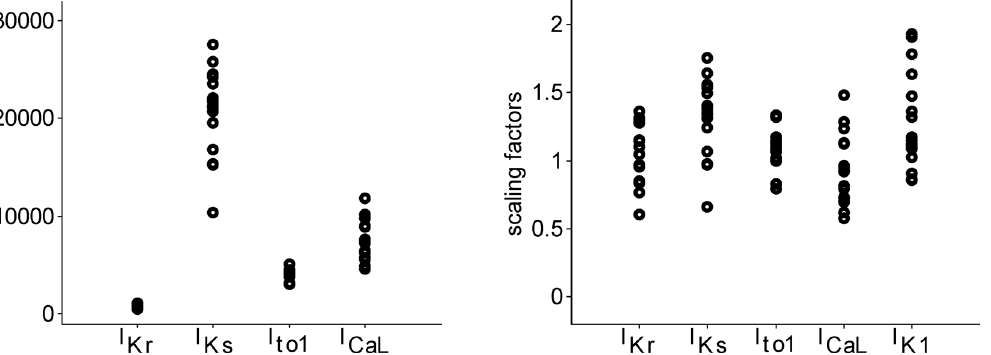
Fig 3. Channel numbers and current conductance scaling factors. Number of channels (left) and scaling factors for current conductances (right) in the seventeen models for I Kr , I Ks , I to1, I CaL and I K1